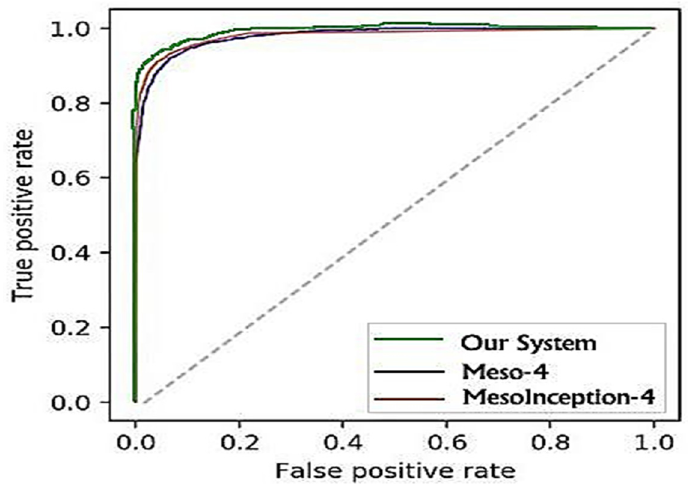
Figure 11. ROC curves of the evaluated classifiers on the Face2Face dataset.